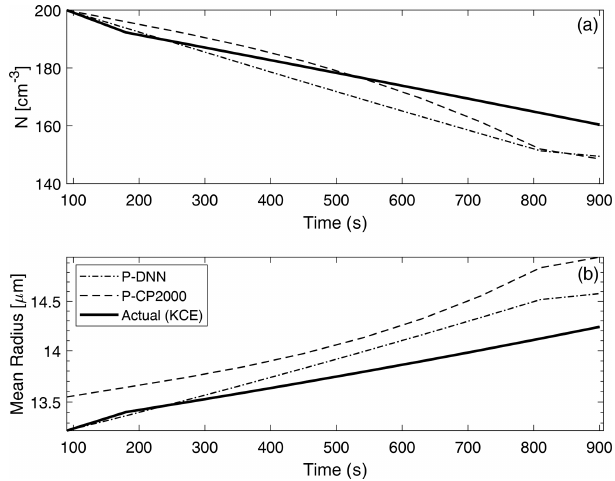
Figure 8. Drop number concentration spectra for P-DNN, P- CP2000 and KCE. The selected times are 300, 600 and 900s from top to bottom. Equation (17) was used to transform the mass density spectra from KCE to the drop number concentration spectra.